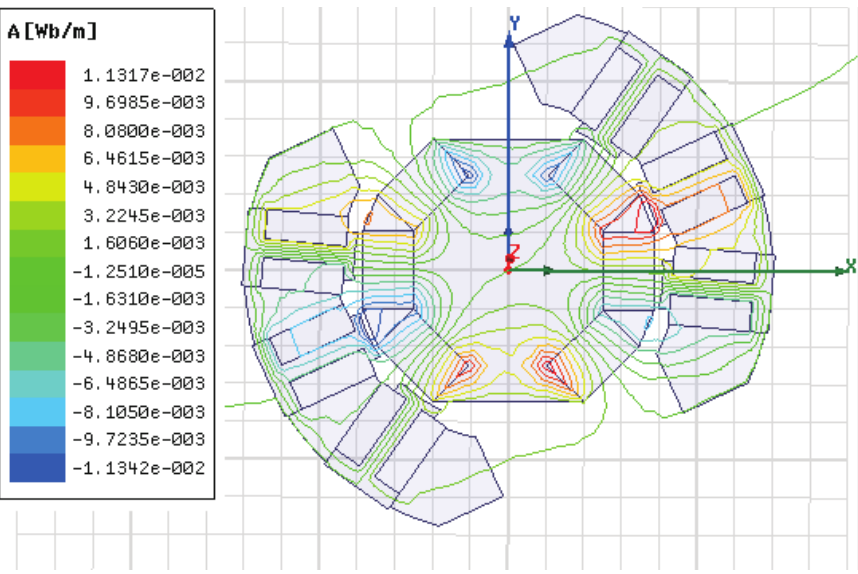
Figure 4. The cross-sectional drawing of the magnetic